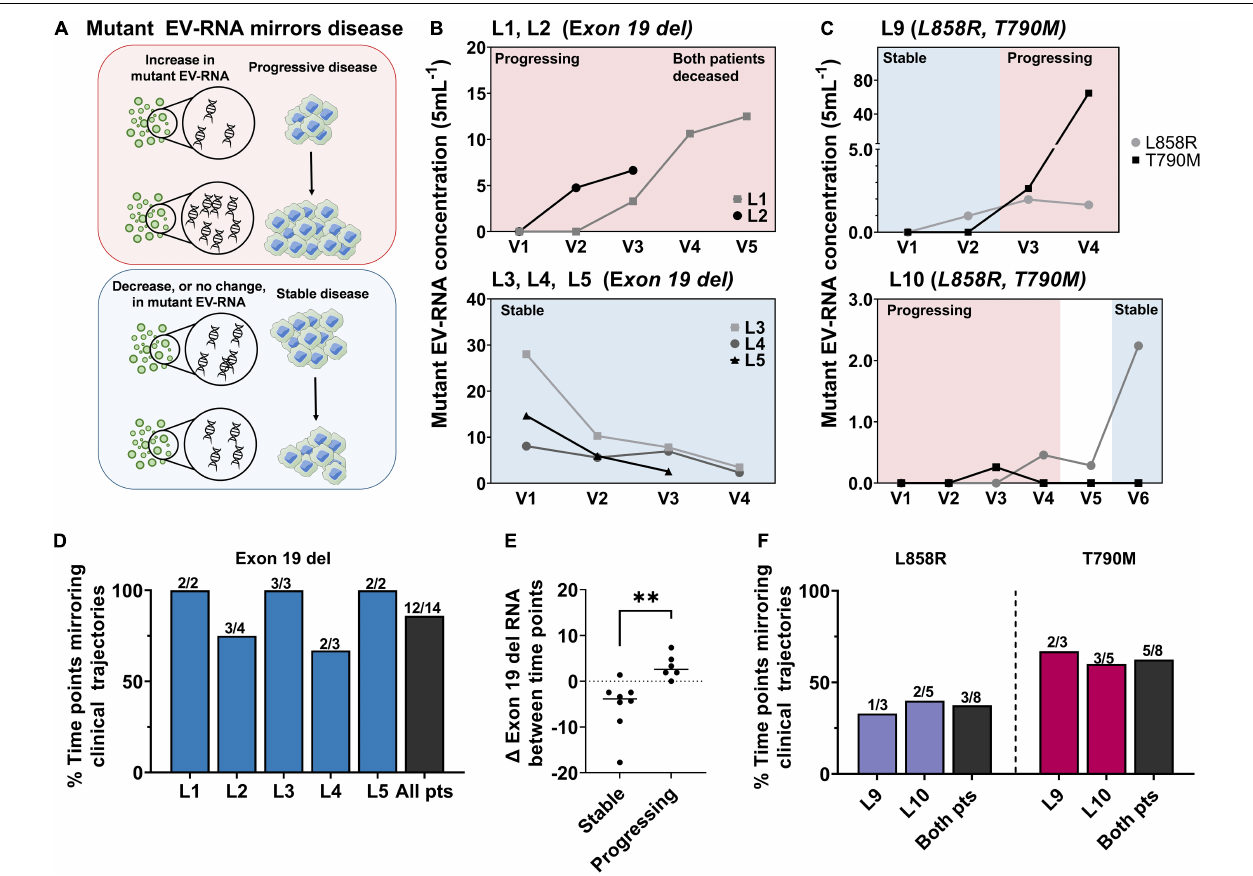
FIGURE 4 | Changes in EGFR mutation burden in EV-RNA mirror disease status. (A) Schematic demonstrating EV-RNA mirroring disease status. An increase in mutant EV-RNA mirrors progressive disease, while a decrease or no change in EV-RNA would mirror stable disease. (B) Mutant EV-RNA concentration for exon 19 del patients across multiple visits for patients with consistently progressive (top) or consistently stable (bottom) disease. (C) Mutant EV-RNA concentration for L858R/T790M in divergent patients, L9 (top) and L10 (bottom) across multiple visits. (D) Percent of EV-RNA samples drawn at a time point when EV-RNA mutation burden mirrors disease status for patients with exon 19 del. (E) Change ( (cid:49) ) exon 19 deletion mutation burden in EV-RNA between time points for patients who are clinically stable compared to progressing, p -value = 0.0059 using an unpaired t -test. (F) Percent of EV-RNA samples drawn at a time point when EV-RNA mutation burden mirrors disease status for patients with L858R and T790M mutations. ** p -value ≤ 0.01.